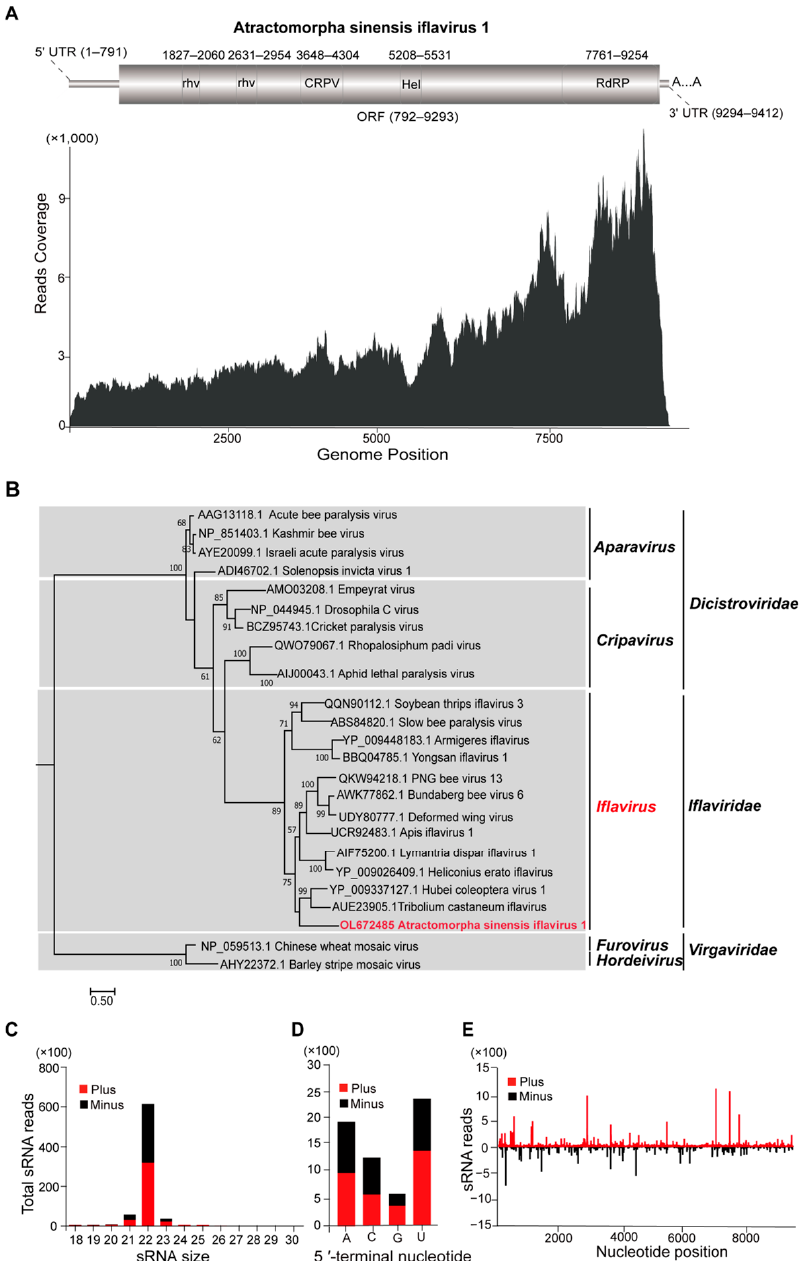
Figure 2. Atractomorpha sinensis iflavirus 1. ( A ) Genetic structure and transcriptome raw read coverage; rhv, picornavirus-like capsid protein; CRPV, CRPV_capsid super family, cricket paralysis virus; Hel, RNA virus helicase core domain; RdRP, RNA-dependent RNA polymerase domain. ( B ) Phylogenetic analysis of ASIV1 and previously reported viruses in the iflavirus based on the conserved RdRP amino acid sequences. Bootstrap values are placed over each node of the tree (when > 50). Scale bars represent percentage divergence, while the ASIV1 identified in this study is indicated with red fonts. ( C ) Size distribution of ASIV1 sRNAs and 5 (cid:48) -terminal nucleotides. ( D ) Preference of 5 (cid:48) -terminal nucleotide. ( E ) Distribution of ASIV1 derived sRNA along the corresponding viral ge-